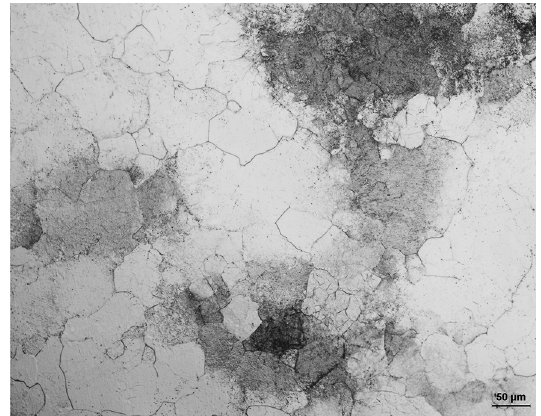
Figure 1. Optical image showing the origin microstructure of as- consolidated PM Ti-5553